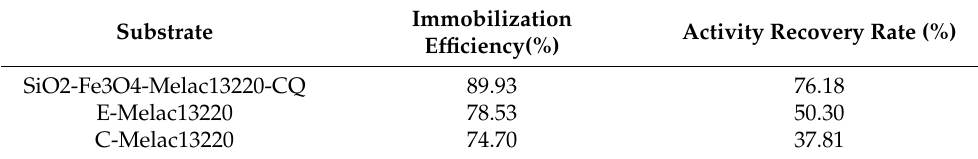
Table 3. The immobilization vitality recovery rates of immobilized